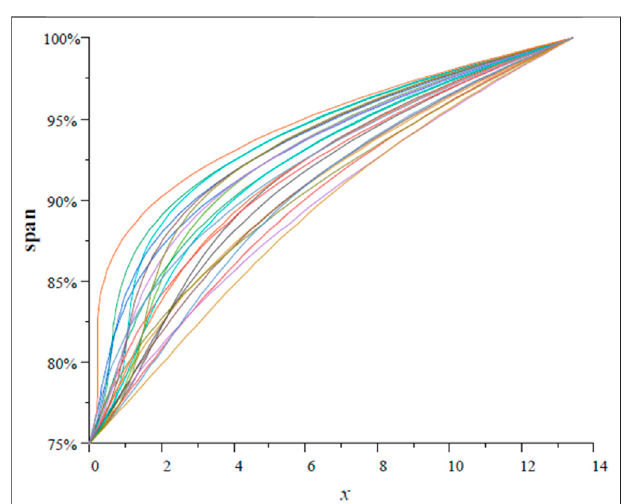
FIGURE 7 | Opt LHD test design ( η ).